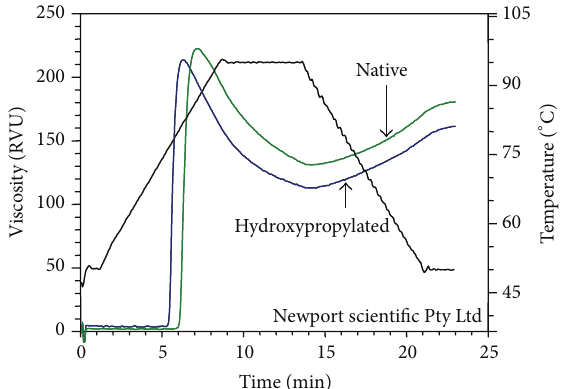
Figure 2: Representative RVA curves of native and hydroxypropy- lated sweet potato starch